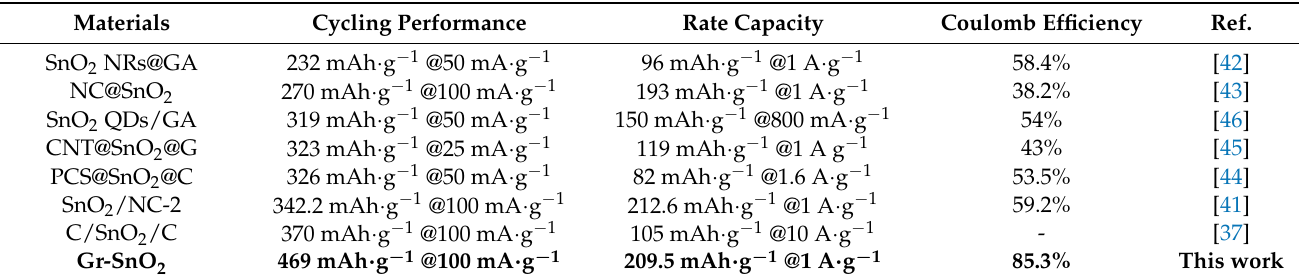
Table 1. Comparison of the electrochemical performances of the SnO 2 -based materials for SIBs. Materials Cycling Performance Rate Capacity